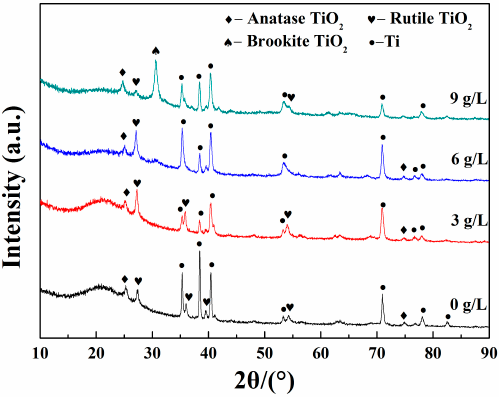
Figure 4. X-ray diffraction (XRD) patterns of MAO coatings formed under various K 2 ZrF 6 concentrations. The XPS measurement was employed to confirm the chemical composition of the MAO coatings.